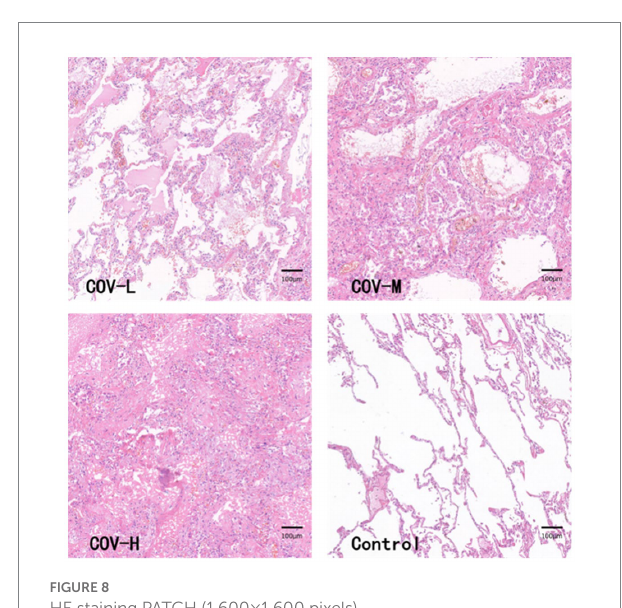
FIGURE 8 HE staining PATCH (1,600 × 1,600